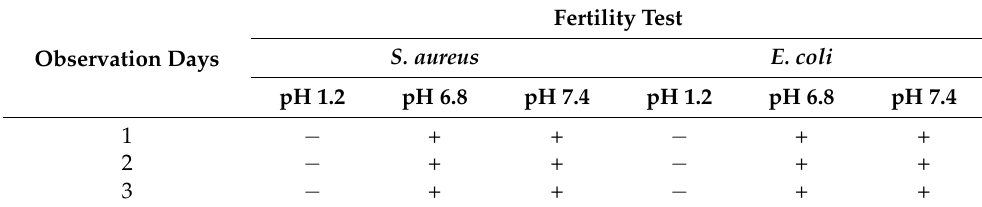
Table 2. Fertility testing data of S. aureus and E. coli in pH 1.2, 6.8, and 7.4.